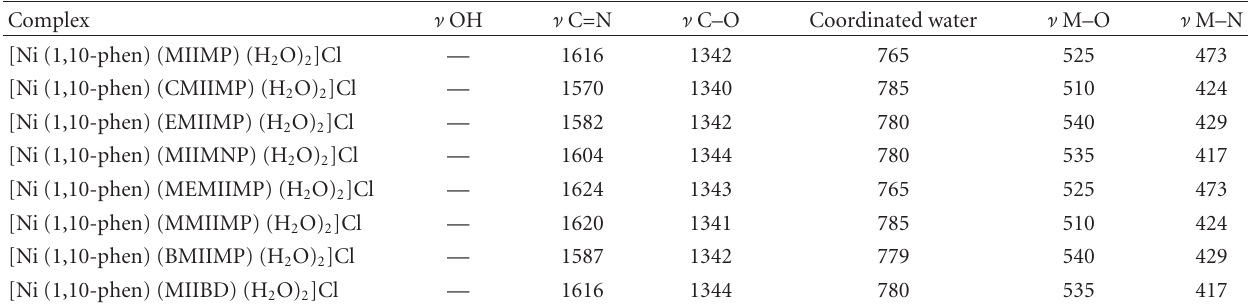
Table 2: IR Absorption frequencies of Ternary Ni(II) Complexes.